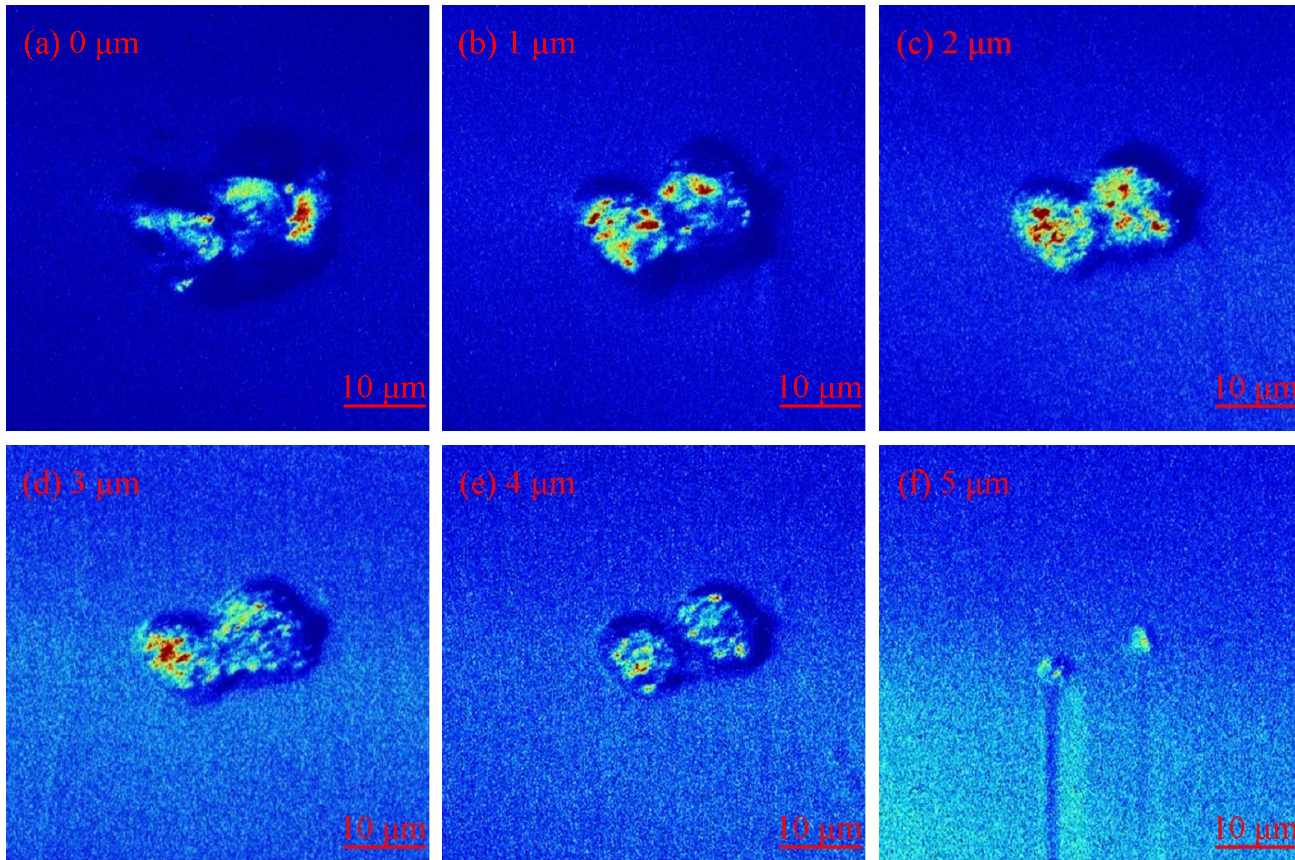
Figure 5. The images of damage fluorescence distribution: ( a ) initial; ( b ) repair depth is 1 µ m; ( c ) repair depth is 2 µ m; ( d ) repair depth is 3 µ m; ( e ) repair depth is 4 µ m; ( f ) repair depth is 5 µ